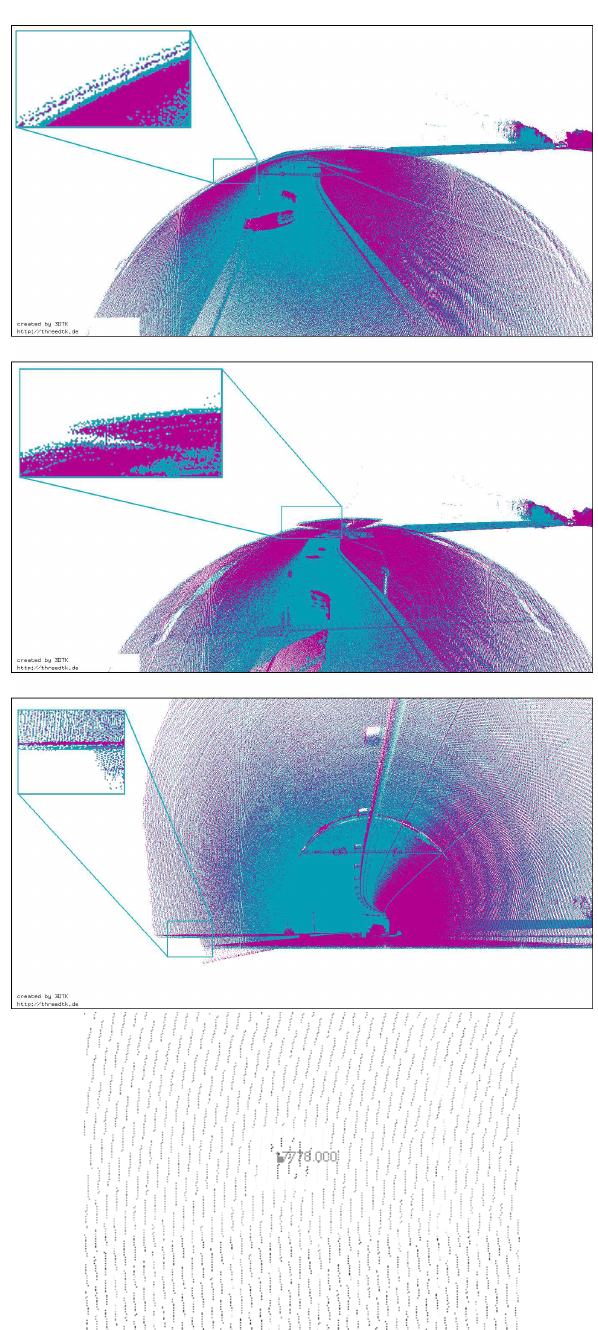
Figure 4. Above: The two images from the top depict discrepan- cies found between point clouds acquired using different scanners on the same run. The third image shows discrepancies between point clouds acquired using the same setup on different runs. Dif- ferent colors denote different point clouds. Below: A ground truth point plotted together with data. The point’s coordinates point to a bolt head in the middle of the painted